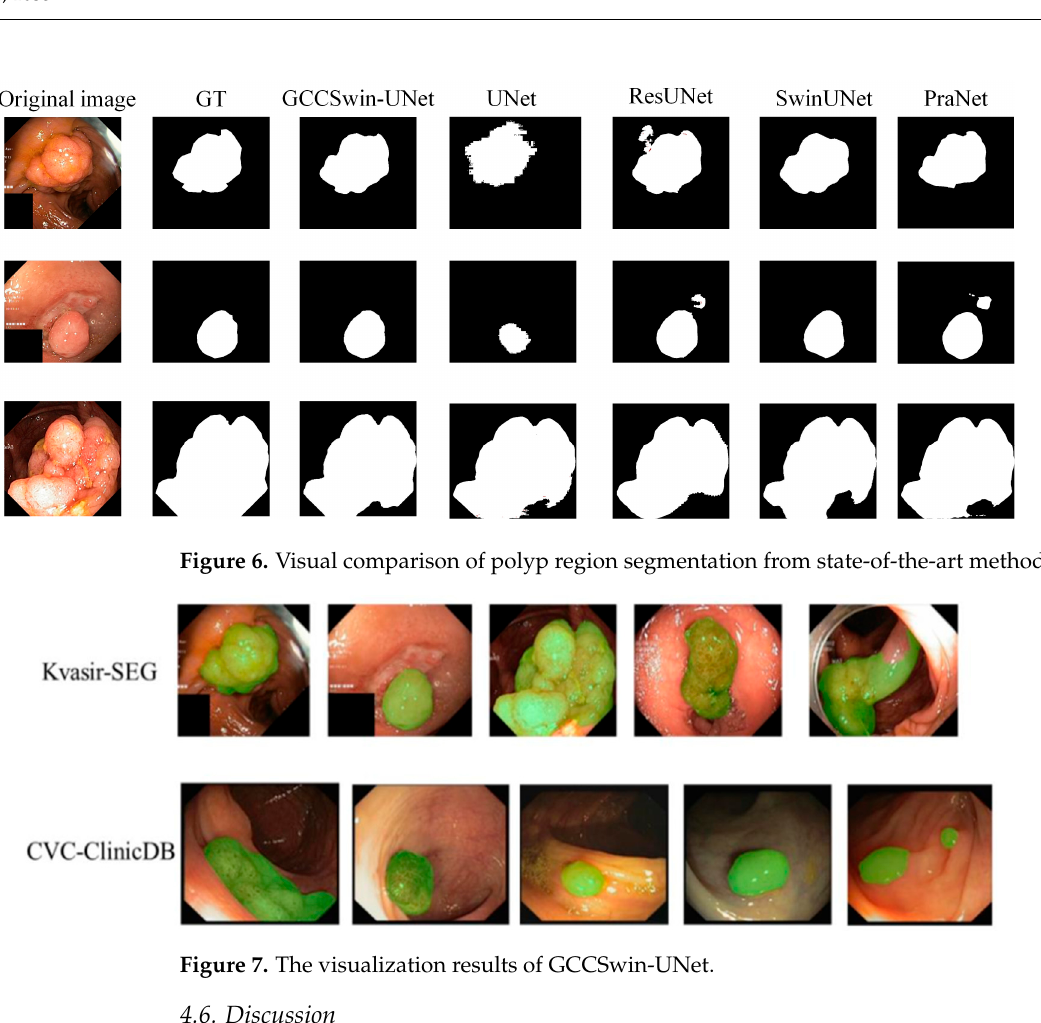
92.13 Bold indicates the best result; ’ ——’ denotes that the corresponding value is not reported. In summary, the GCCSwin-UNet model has a stronger ability to interact with seman- tic information globally and over long distances, and is be tt er than other methods for de- tail extraction, resulting in be tt er segmentation results. (b) Qualitative analysis